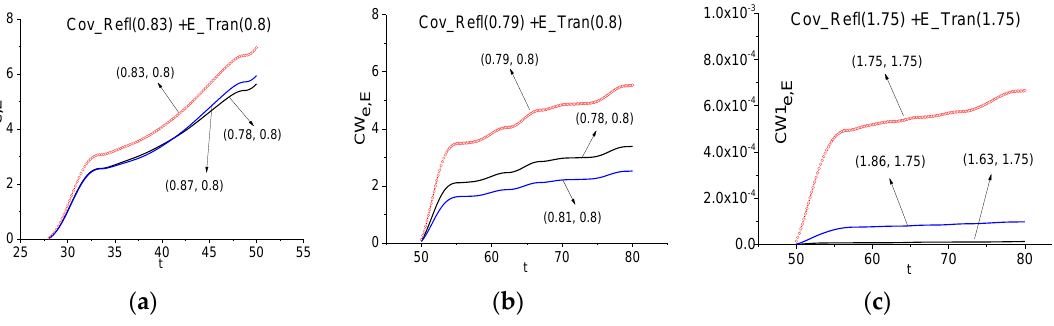
Figure 21. Time-dependent ICC CW e,E ( a ), ( b ) and CW 1 e,E ( c ) calculated for the frequencies ν = 0.83 ( a ), 0.79 ( b ), 1.75 ( c ) in the time intervals t = [28, 80] ( a ), [50, 100] ( b ), ( c ) for the signal reflected from the covered medium (Cov_Refl) and the standard signal transmitted through the non-covered medium (E_Tran).